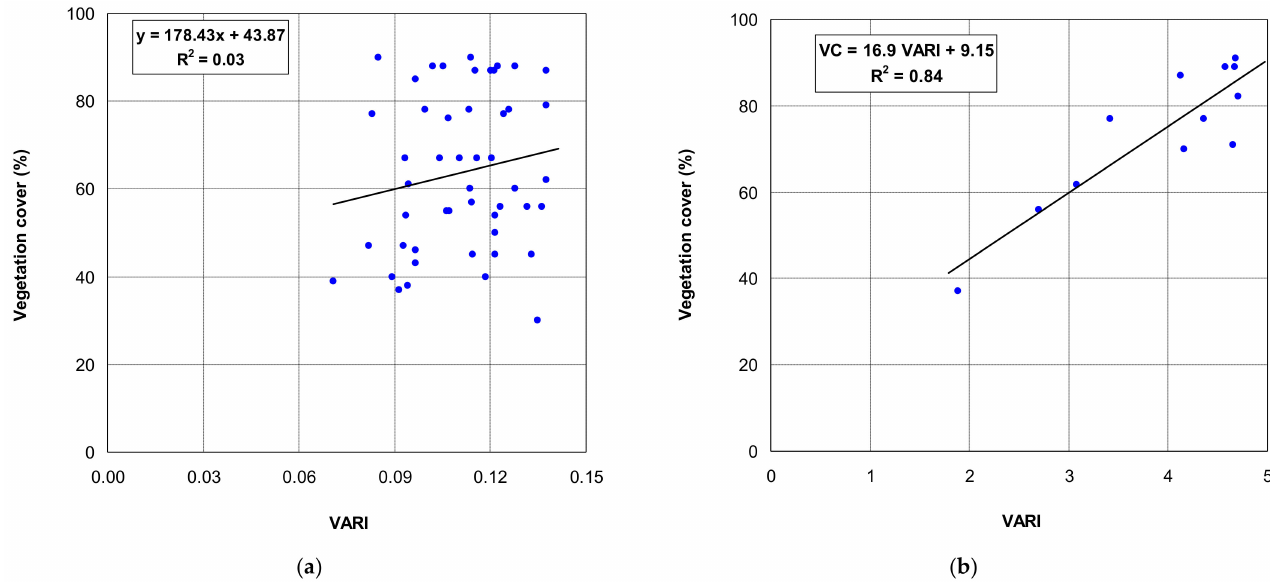
Figure 7. Correlations between VARI and vegetation cover at catchment ( a ), and hillslope ( b ) scales surveyed by LANDSAT8 and UAV images (2016) in Sierra de Los Donceles forest (Castilla-La Mancha,